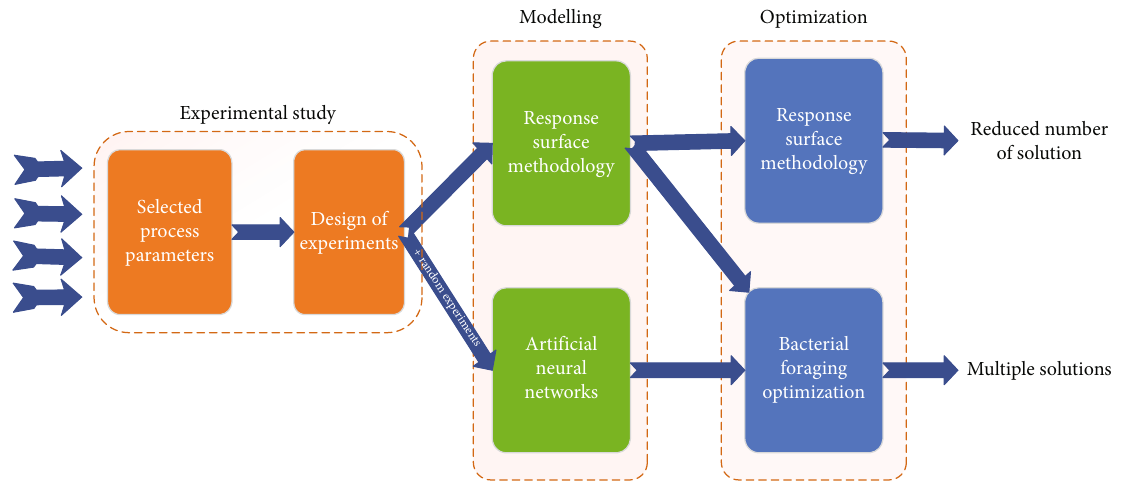
Figure 1: Work fl ow for the application of the di ff erent strategies used in this work. Table 1: The speci fi c surface areas and porous characteristics of commercial activated